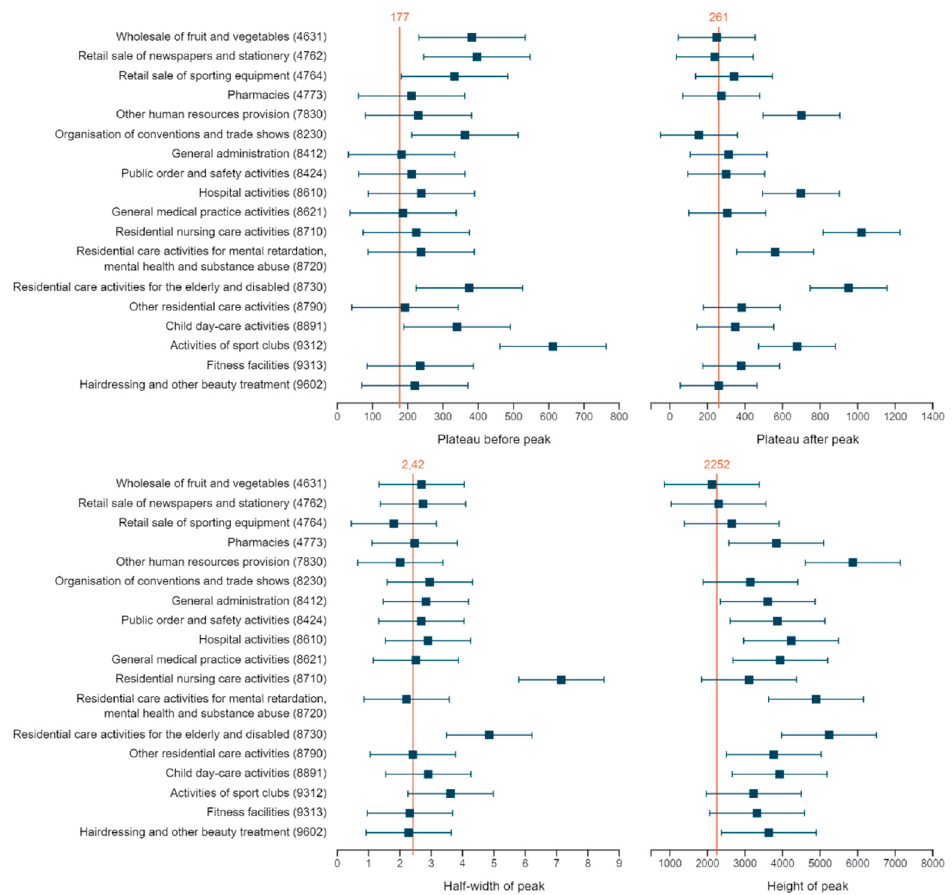
Figure 2. Forest plots of characteristics of the longitudinal profile of selected sectors. The plateaus before and after the peak are related to the 14-day incidence. The height of the peak is the 14-day incidence at the highest moment in the curve and the half-width of the peak is the number of weeks it takes for the curve to reduce the 14-day incidence by a